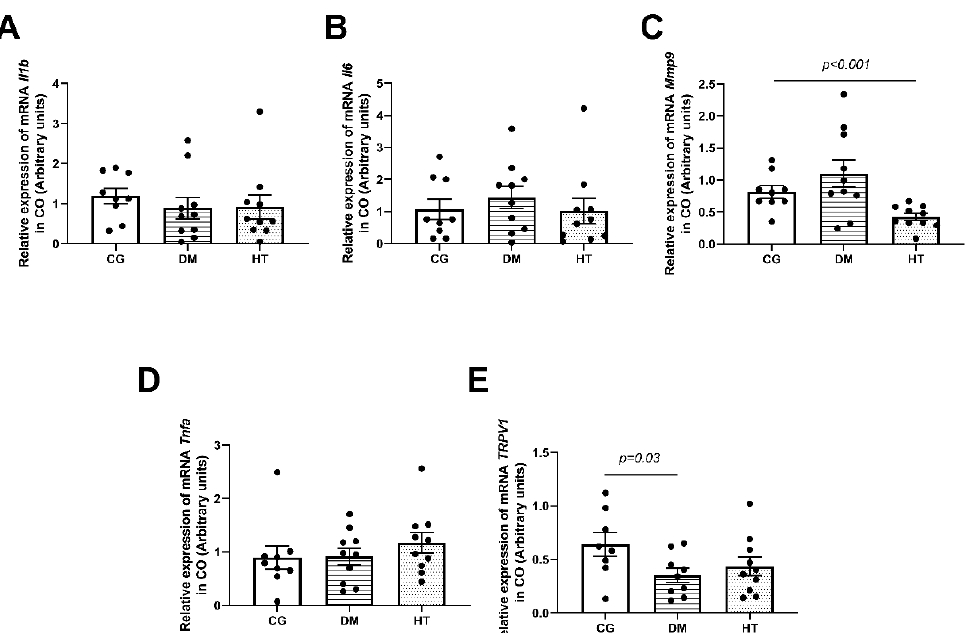
Figure 1. The relative mRNA expression of pro-inflammatory cytokines in CO of the DM, HT, and control groups. The data revealed lower expression of Mmp9 mRNA in HT group ( p < 0.001) ( C ), and no changes in the Il1b ( A ), Il6 ( B ), and Tnf ( D ) compared to the CG. ( E ) TRPV1 relative mRNA expression in the CO. The data revealed a lower expression of TRPV1 mRNA in the DM group ( p = 0.03). In all tests, n = 10/animals per group. The comparisons were made between DM or HT groups and CG using the Mann–Whitney U test. Each animal value is represented by a black dot in the figure.